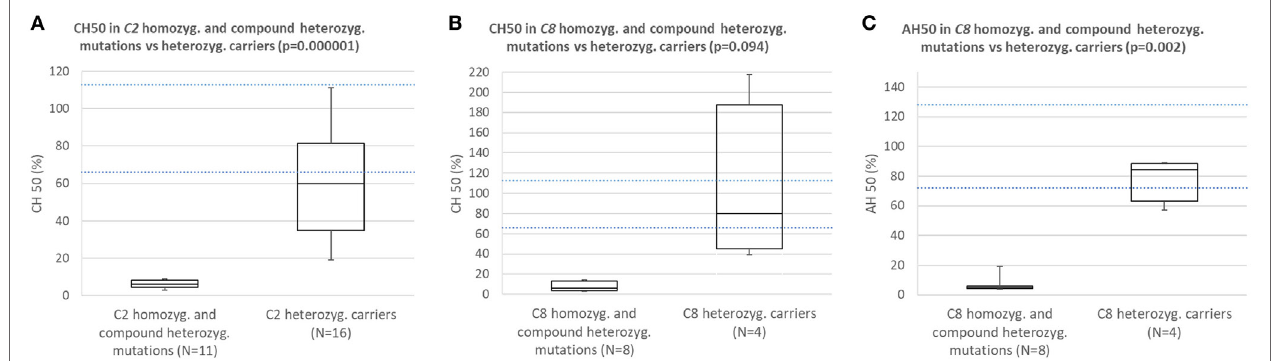
FigUre 2 | (a) Comparison of CH50 between subjects with homozygous or compound heterozygous mutations in C2 and heterozygous carriers of C2 deficiency. (B) Comparison of CH50 between subjects with homozygous mutations in C8 and carriers of heterozygous mutation causing C8 deficiency. (c) Comparison of AH50 between subjects with homozygous mutations in C8 and carriers of heterozygous mutation causing C8